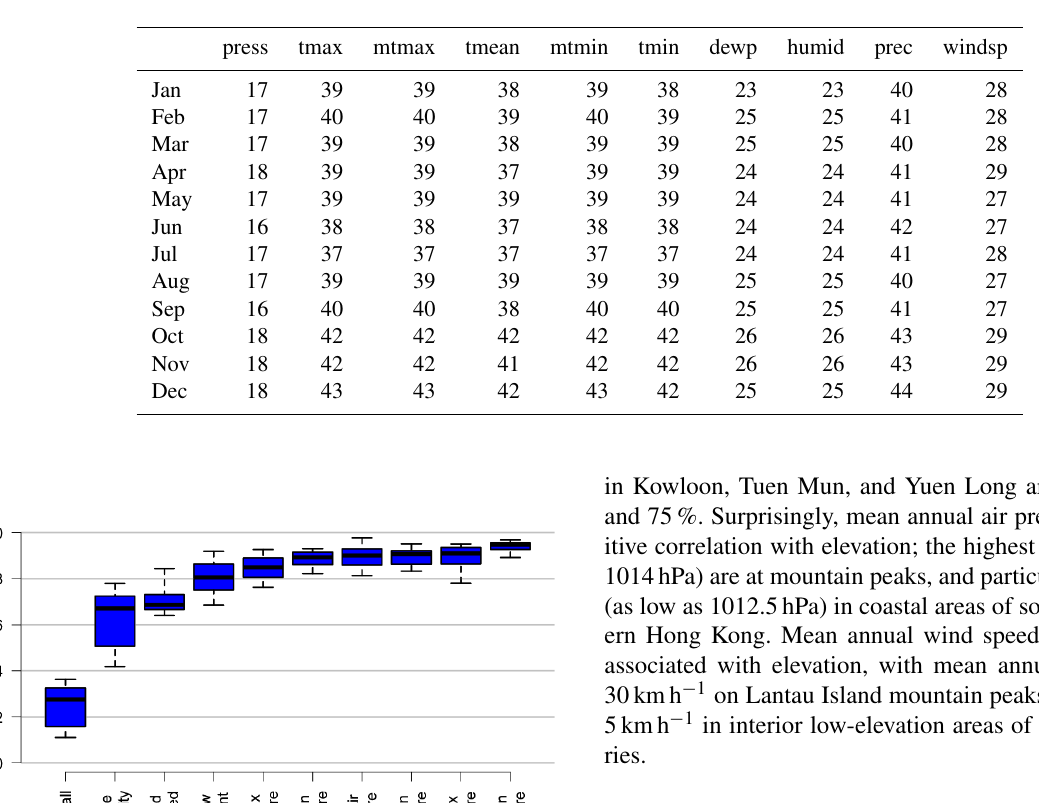
Figure 2. Comparison of the average high of warmest month (bio5) model results for Hong Kong. Panel (a) is from our newly interpolated climate models at 30m resolution, while panel (b) is 1km resolution data available as part of WorldClim 2 (Fick and Hijmans, 2017). Not only is the resolution markedly improved, but the temperature values are also more varied, for instance on the large southern islands. Table 2. Number of weather stations that contributed data for each climate model.